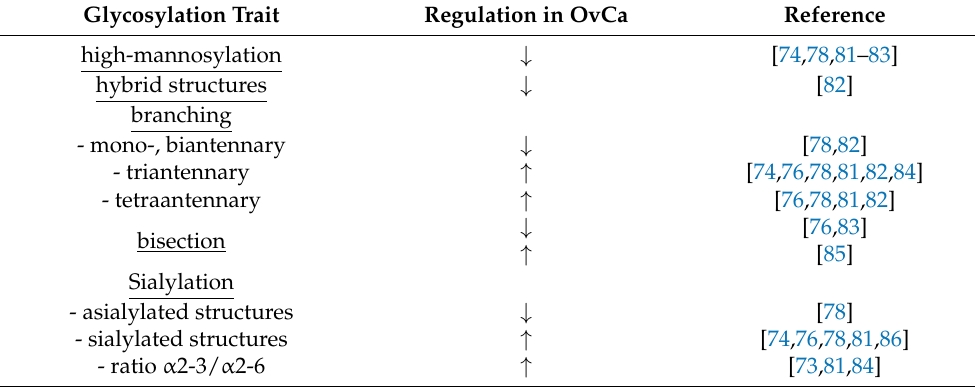
Table 2. Serum total N -glycan biomarkers for ovarian cancer. ↑ - upregulation, ↓ -